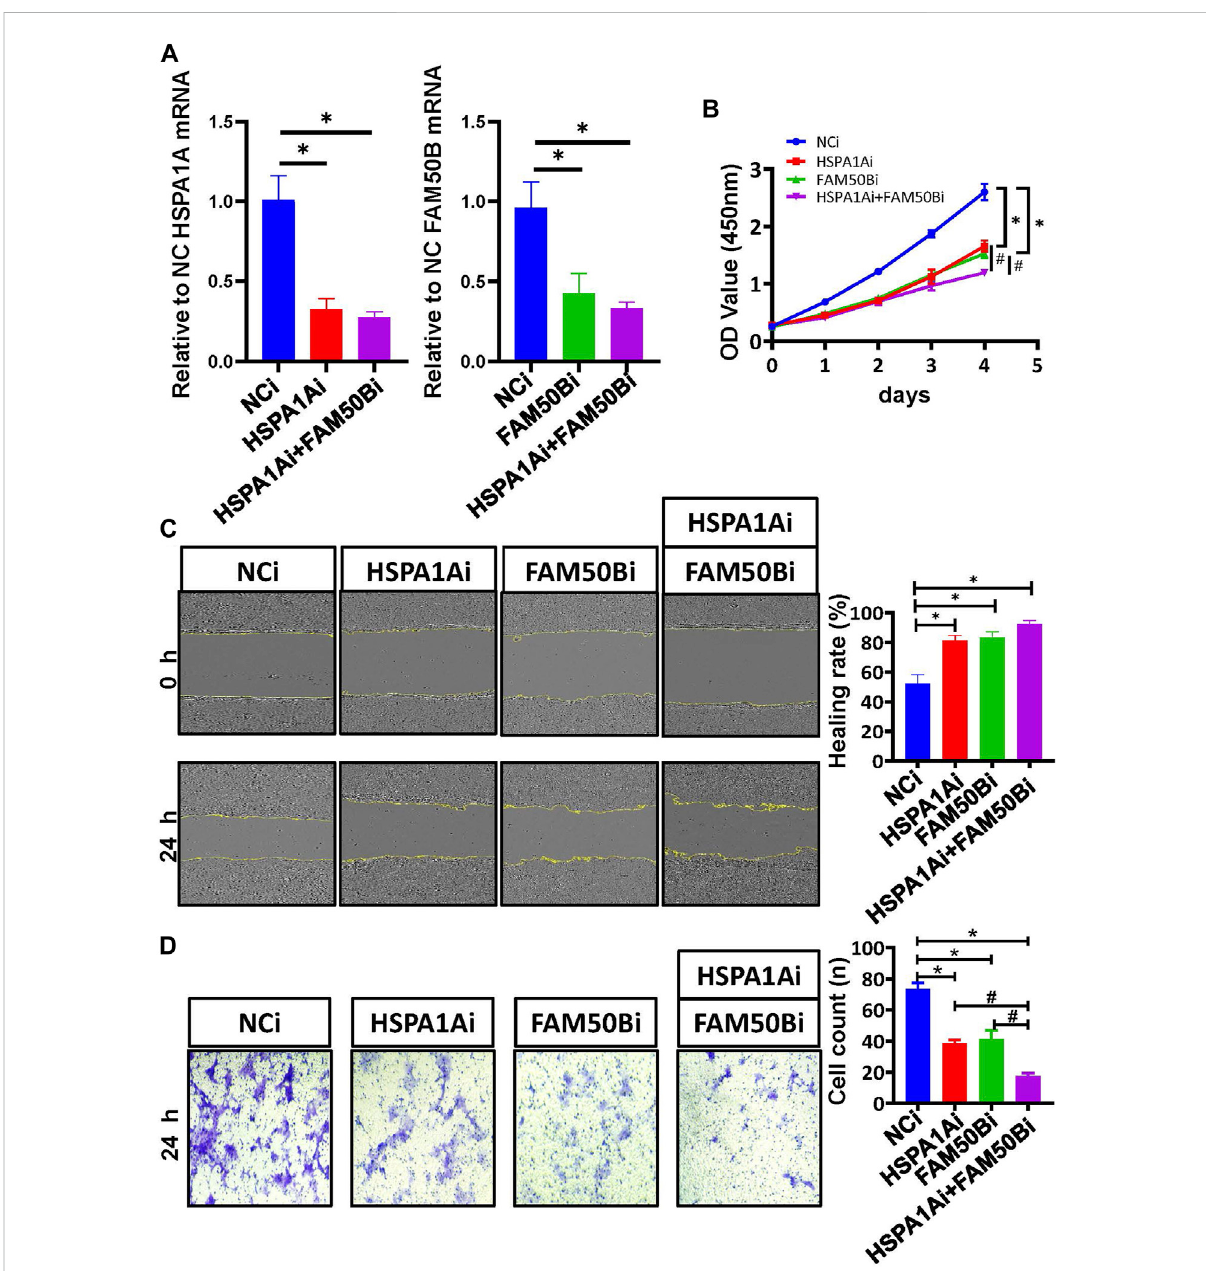
FIGURE 9 Downregulation of HSPA1A and FAM50B inhibits the proliferation and migration of Caco2 cells. Caco2 cells were transfected with control siRNA, HSPA1A siRNA, and FAM50B siRNA, respectively, or co-transfected with HSPA1A siRNA and FAM50B siRNA. (A) The mRNA levels of HSPA1A and FAM50B in Caco2 cells after transfection. (B) Cell proliferation were assessed by CCK8 assays (n ≥ 4). (C and D) The cell migration was detected by scratch (C) and transwell assays (D) ( n = 3). * p < 0.05 vs. NCi group. # p < 0.05 vs. HSPA1Ai + FAM50Bi. Data are mean ±